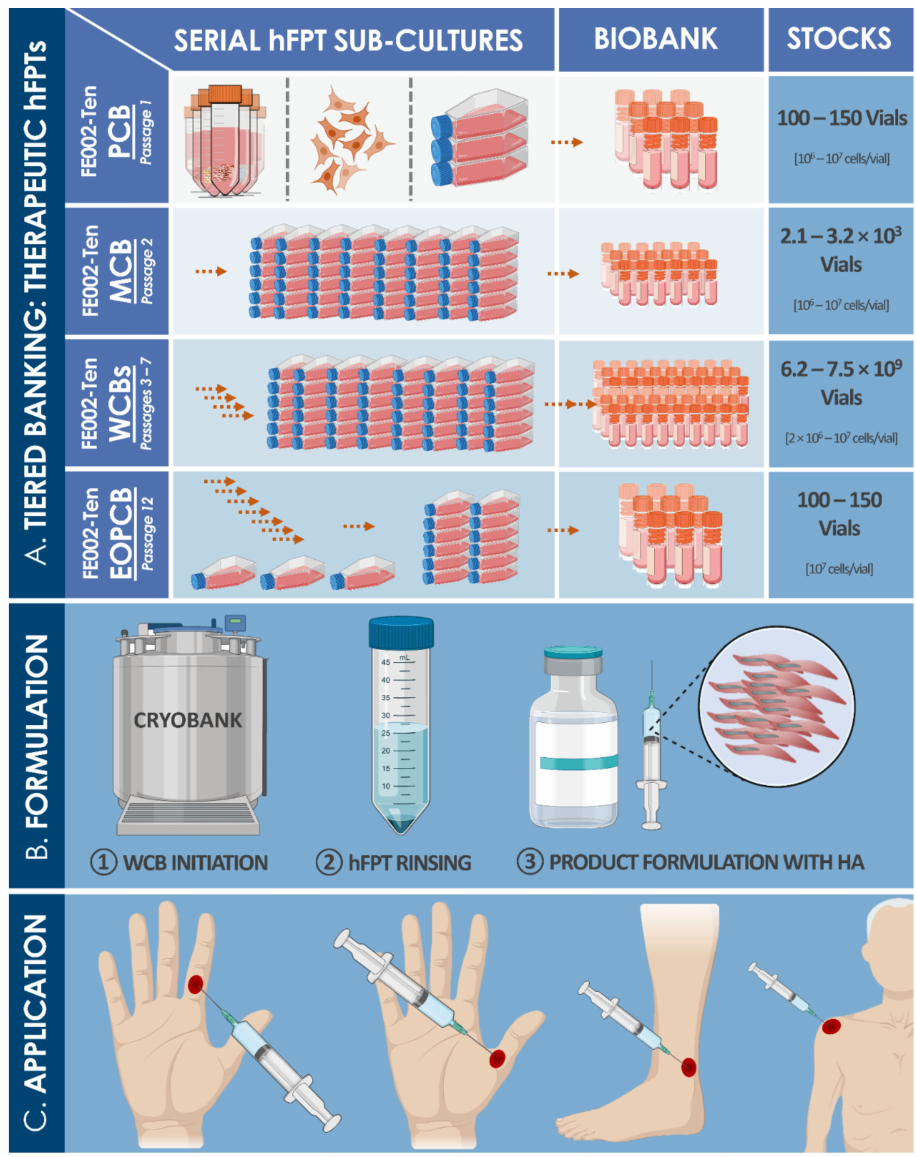
Figure 3. Schematic workflow representing optimized and standardized multi-tiered hFPT banking (e.g., enzymatically isolated FE002-Ten cell type) and standardized transplant preparation for tendon injury and defect treatment. ( A ) Important in vitro optimization steps enabled selection of optimally adapted FBS lots, cell culture surfaces, and culture conditions, ensuring optimal efficiency of manufacturing. Appropriate technical specifications and rigorous testing enable the man- ufacture of highly homogenous and stable therapeutic cellular materials to be applied in regenerative medicine (e.g., extemporaneous on-demand production of standardized transplants for hand or articulation tendons) or in biotechnological applications. Particularly, specifically devised multi-tiered hFPT biobanking workflows enable the rapid generation of therapeutic materials for the potential treatment of millions of patients. ( B ) For extemporaneous standardized transplant manufacture, hFPT WCB vials are removed from liquid nitrogen storage, cells are rinsed for cryopreservation medium removal, and further formulated with adapted cell delivery vehicles (e.g., HA-based hydrogels) in view of rapid (i.e., within 72 h of cell initiation) clinical delivery of viable cellular constructs. ( C ) Following standardized transplant product preparation, localized clinical administration should occur rapidly for management of defects in hand tendons, rotator cuff tendons, or Achilles’ tendons. EOPCB, end of production cell bank; FBS, fetal bovine serum; HA, hyaluronic acid; hFPT, human fetal progenitor tenocytes; MCB, master cell bank; PCB, parental cell bank; WCB, working cell